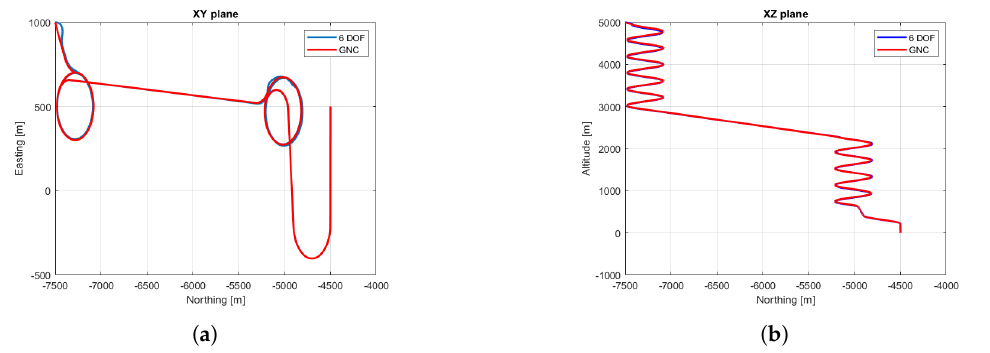
Figure 16. Partial views of the 6 DOF trajectory of the parafoil with control saturation and no wind. ( a ) xy − plane view; ( b ) xz − plane